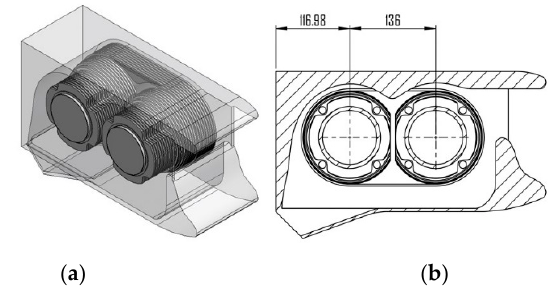
Figure 2. Model assembly: ( a ) Isometric view; ( b ) Side view.